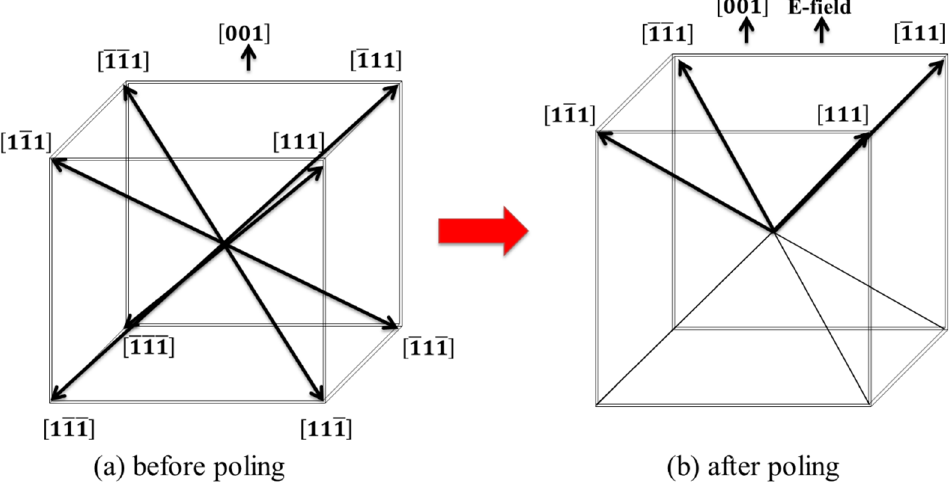
Figure 7. Schematics of domain configuration in the rhombohedral 0.92NBT-0.08KBT crystal: ( a ) before poling, and ( b ) after poling along the <001> direction. Reprinted with permission from [25]. Copyright 2011 AIP Publishing